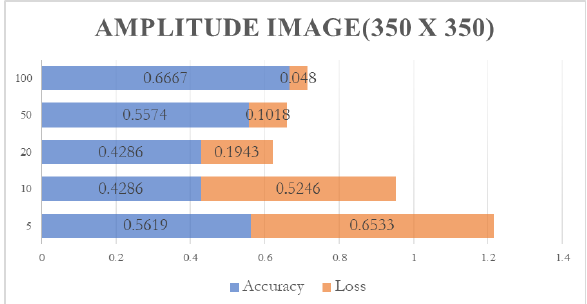
Figure 25 . Graph of Amplitude Image (350X 350).